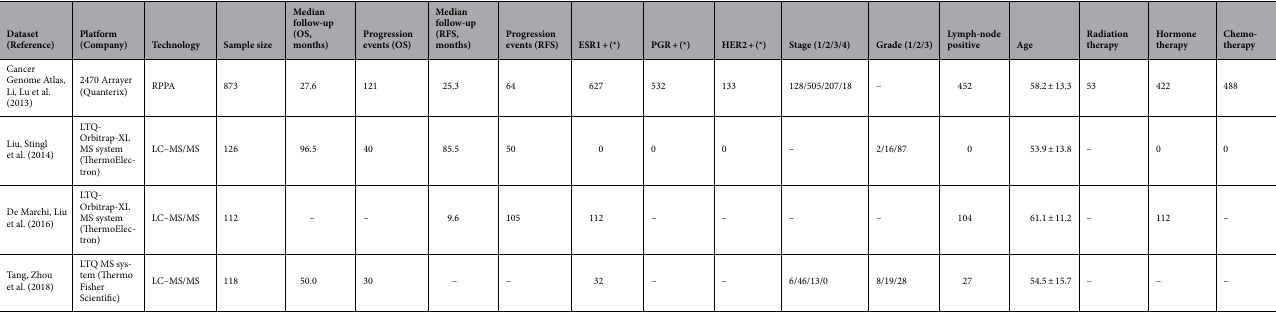
Table 2. Detailed clinical features of the four protein datasets eligible for this analysis. OS: overall survival, RFS: relapse-free survival. *ER, PGR, HER2 receptor status was identified using both gene expression